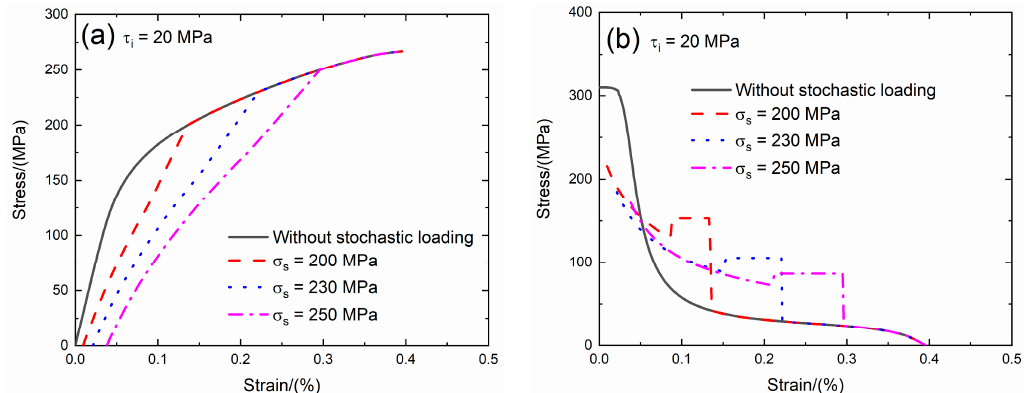
Figure 5. ( a ) The tensile stress–strain curves; ( b ) the tangent modulus versus strain curves; ( c ) the interface debonding fraction versus stress curves; and ( d ) the broken fibers fraction versus stress curves of SiC/SiC composite for conditions without stochastic loading and with stochastic loading of σ s = 200, 230 and 250 MPa when τ i = 15 MPa.